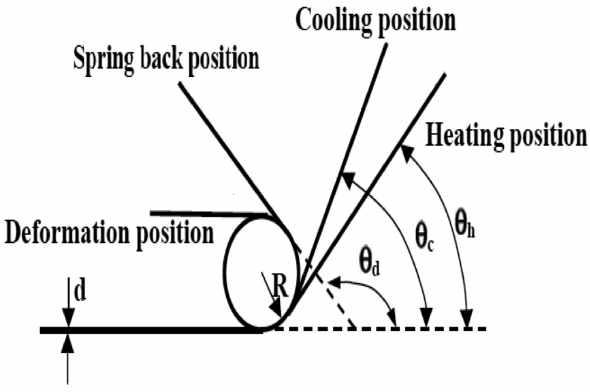
Figure 1: Schematic illustration of the three-point bend test SME